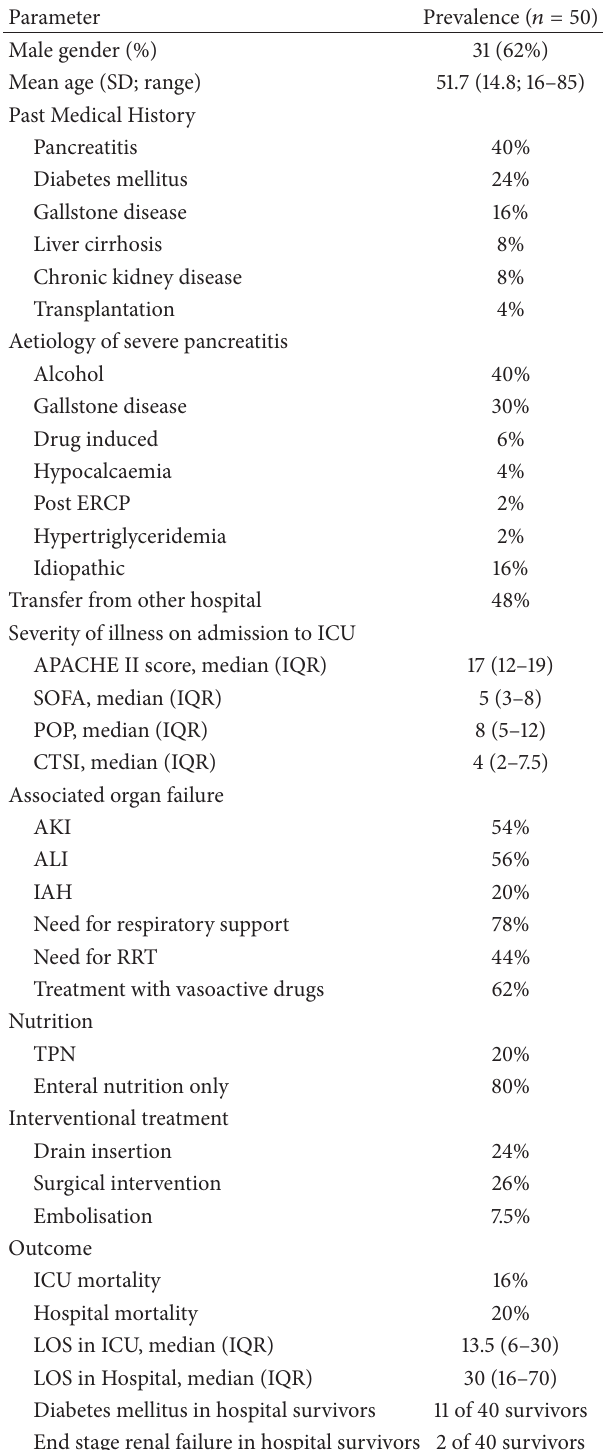
Table 1: Baseline characteristics and outcomes.